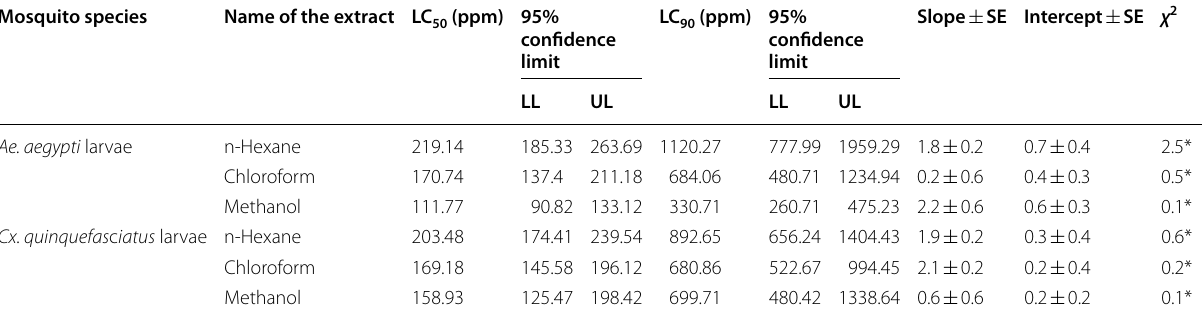
Table 1 Lethal concentration (in ppm) of crude extracts of leaves of P. pterocarpum against the third-instar larvae of Ae. aegypti and Cx. quinquefasciatus